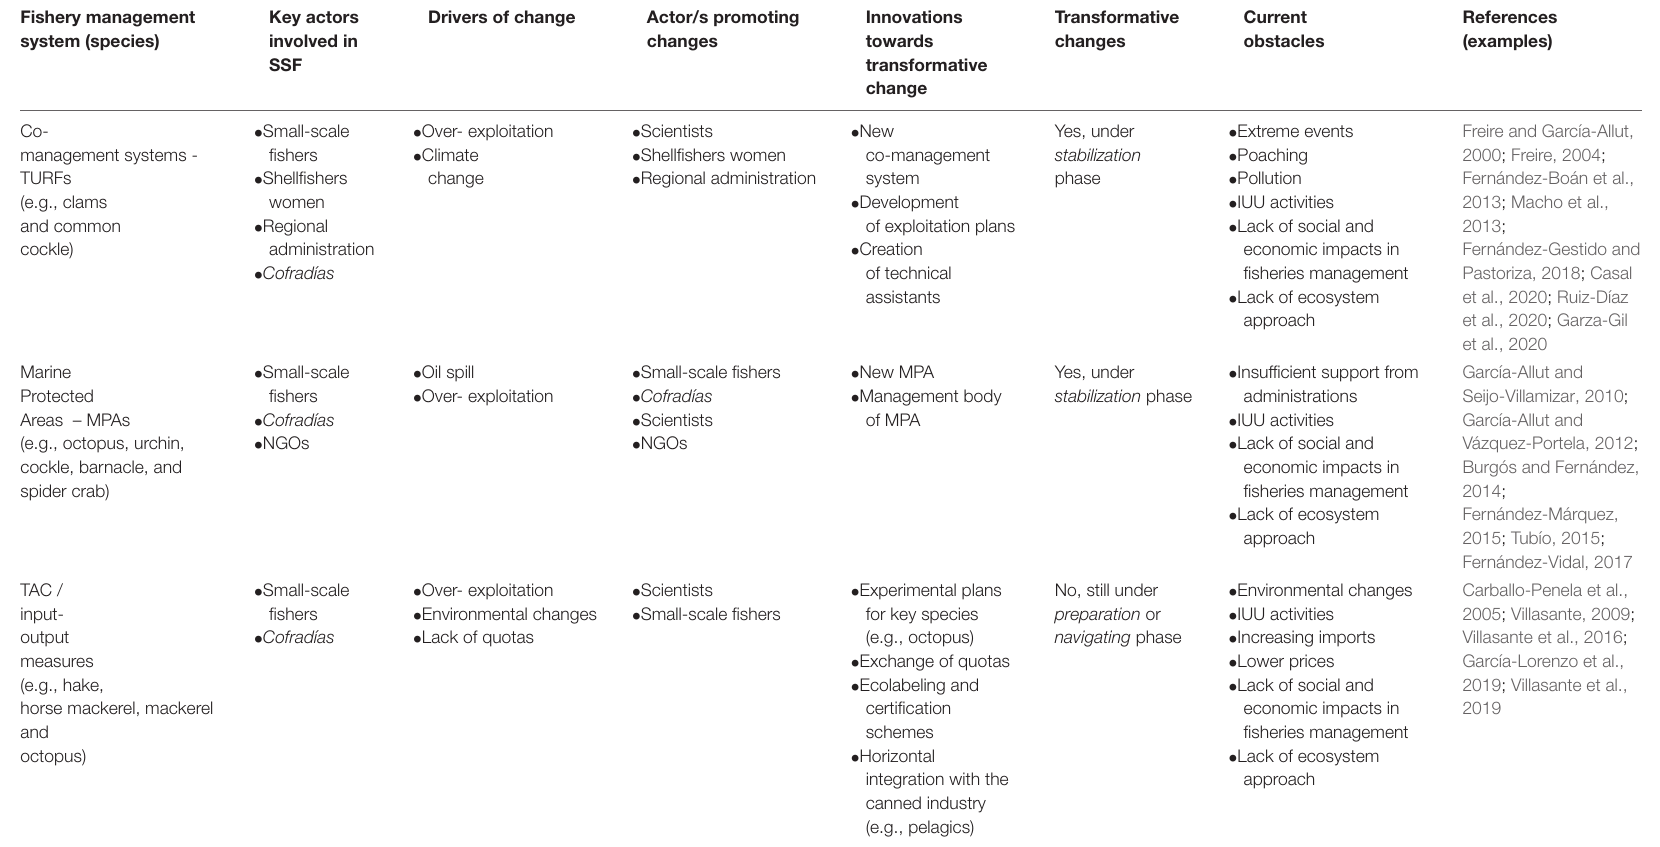
TABLE 3 | Summary of main drivers, actors, and obstacles for transformative changes of Galician small-scale fisheries. Fishery management system